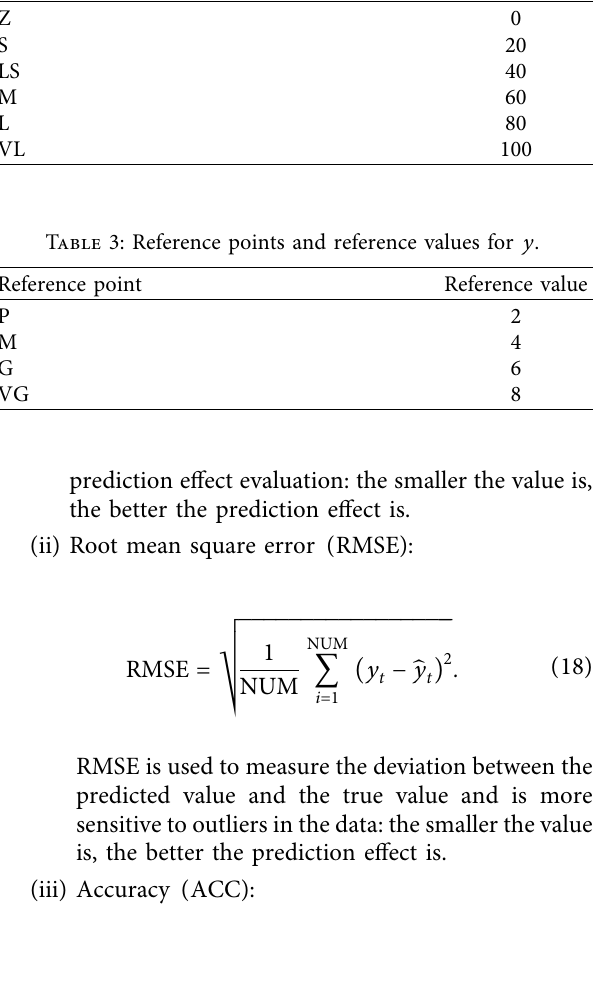
Table 2: Reference points and reference values for x